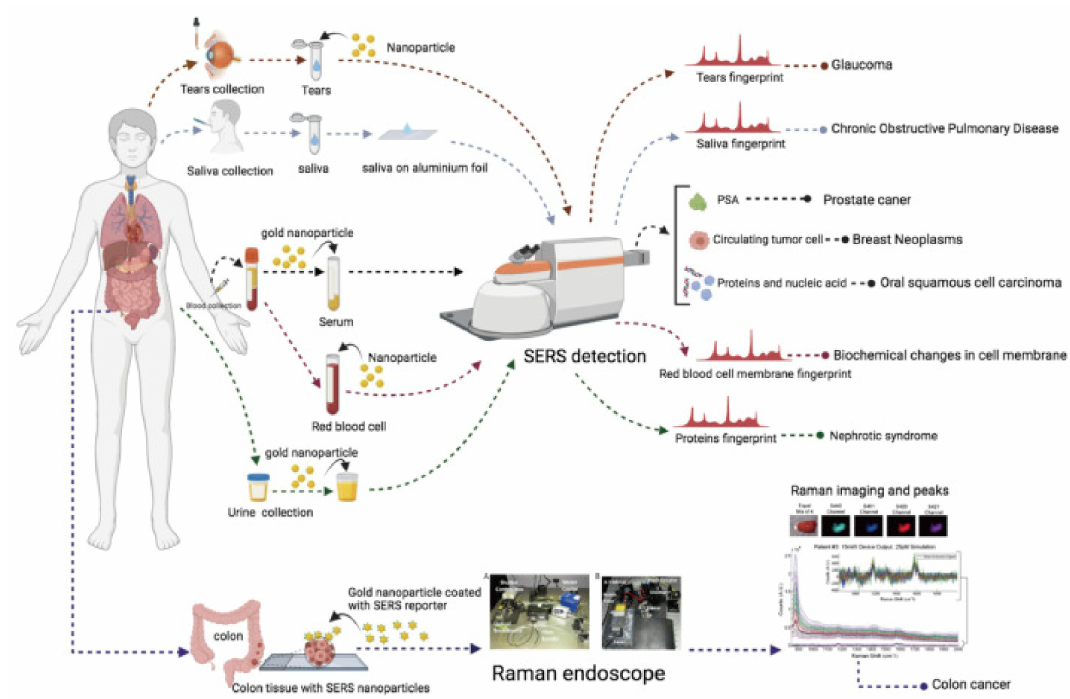
Figure 2. Application of surface-enhanced Raman scattering spectroscopy (SERS) in clinical trials. Reprinted by permission from